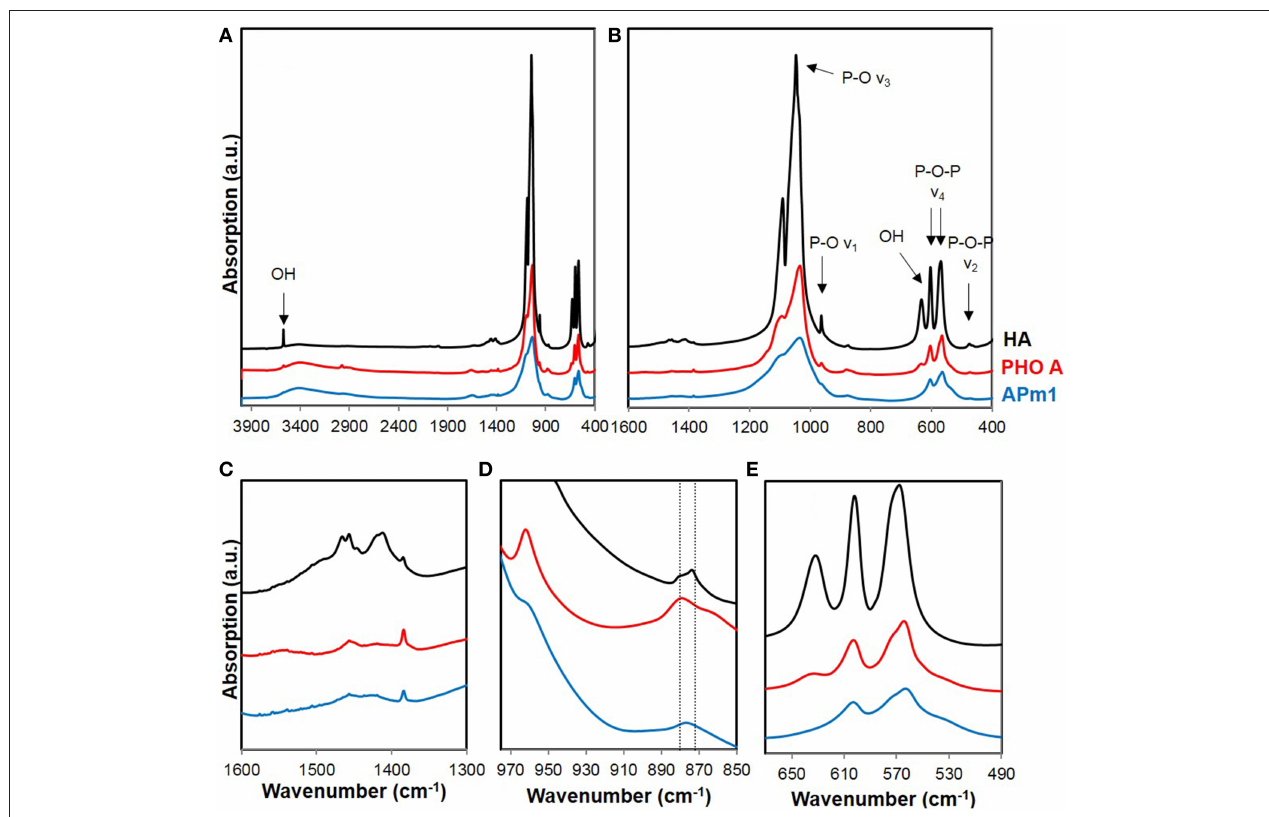
FIGURE 7 | (A) Full FT-IR spectra of reference HA (in black) and Ca-phosphate precipitates formed in the presence of APm1 (in blue) and PHO A (in red), after 7 and 2 days of incubation in the calcification medium, respectively. (B–E) are close-ups of different frequency domains. The vertical lines in (D) correspond to the frequency positions of vibration bands assigned to A-type and B-type carbonate groups in